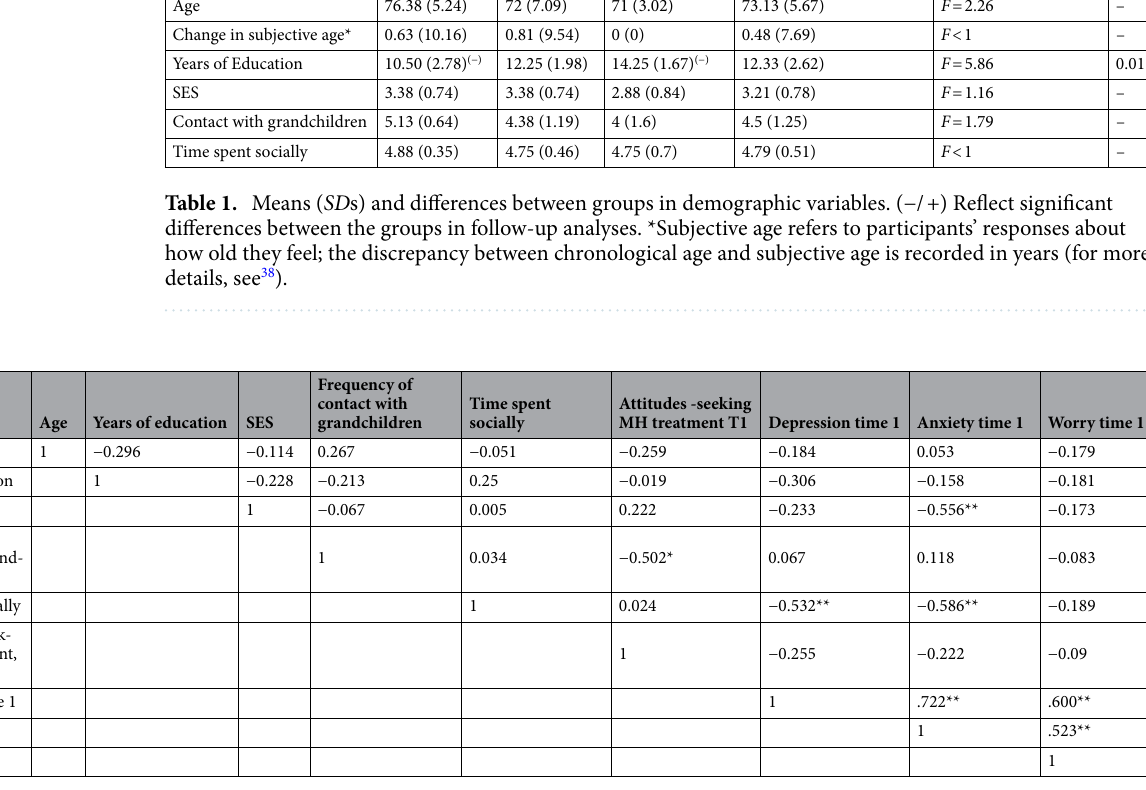
Table 2. Correlations between research variables at Time 1 and the demographic variables. * p < .05, ** p < .01.